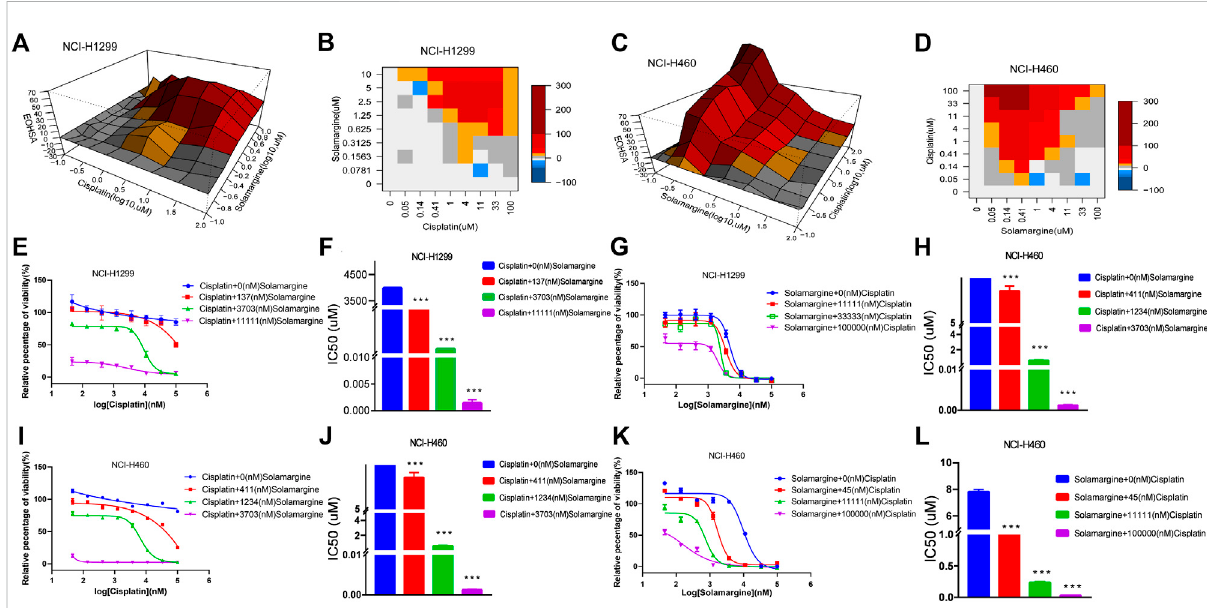
FIGURE 5 Synergy effects of Solamargine and Cisplatin on cell viability of NCI-H1299 and NCI-H460. (A – D) The surface plot and heatmap show the Excess over the Highest Single Agent (EOHSA) of Solamargine and Cisplatin combination in NCI-H1299 and NCI-H460 cells. (E – H) The dose- response curve of Solamargine/Cisplatin in the presence of Cisplatin/Solamargine in NCI-H1299 cells. (I – L) The dose-response curve of Solamargine/Cisplatin in the presence of Cisplatin/Solamargine in NCI-H460 cells.